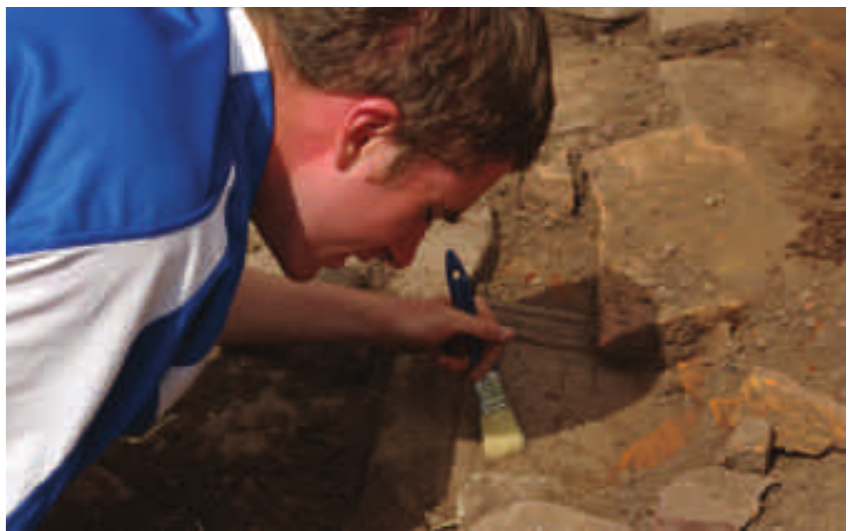
Figure 8 The building inscription under excavation by Cardiff student James Goodsell